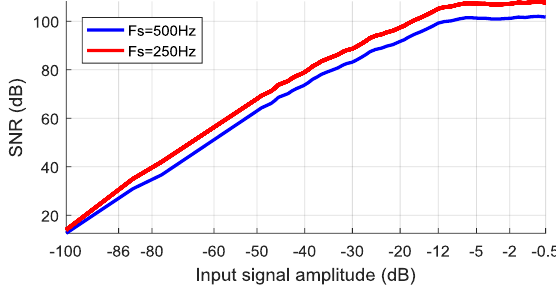
Figure 11. Signal-to-noise ratio (SNR) evaluation results.